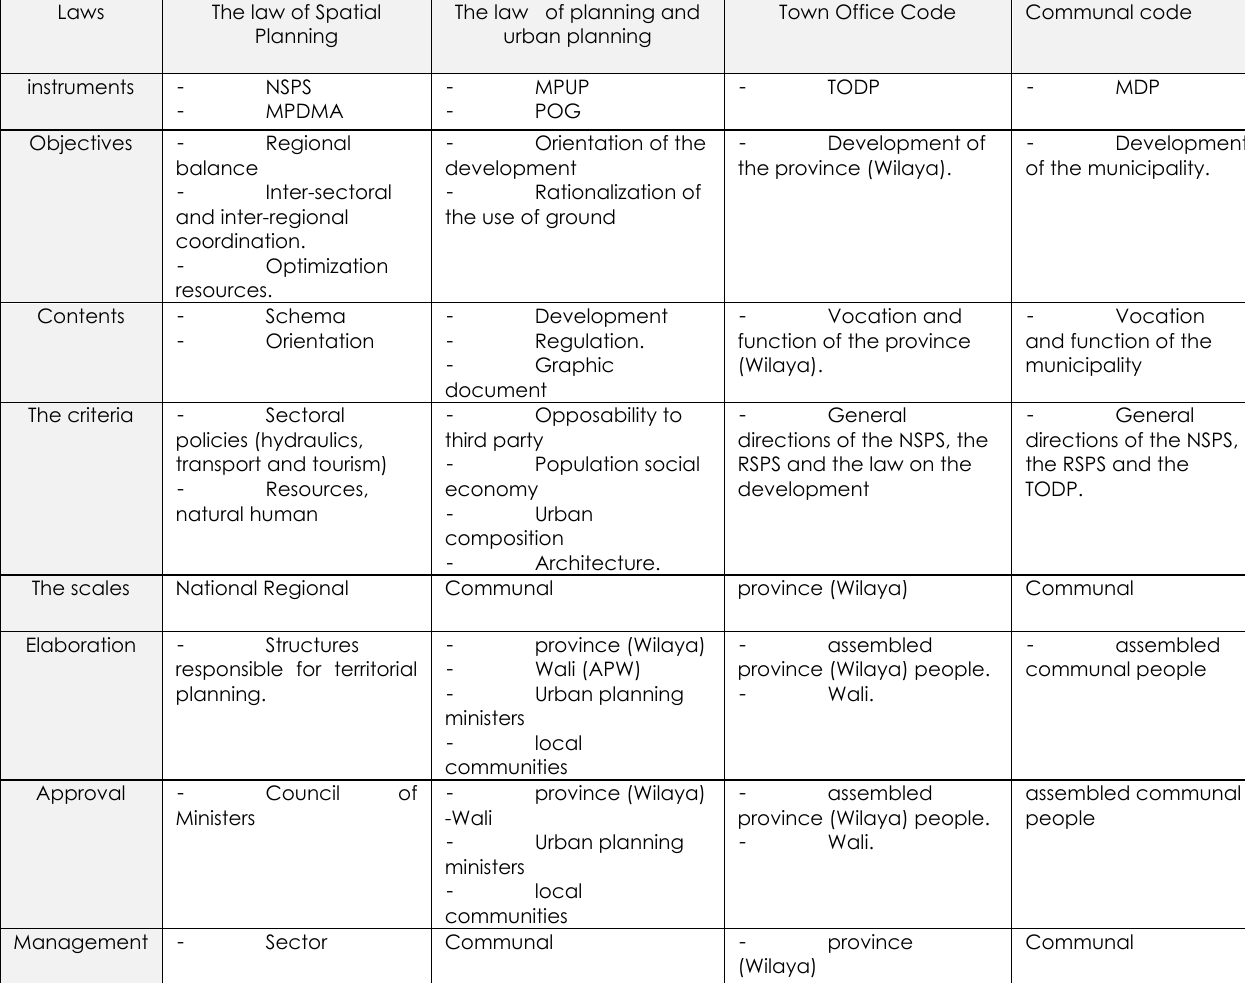
Table 3. Urban and Regional Planning System in Algeria Laws